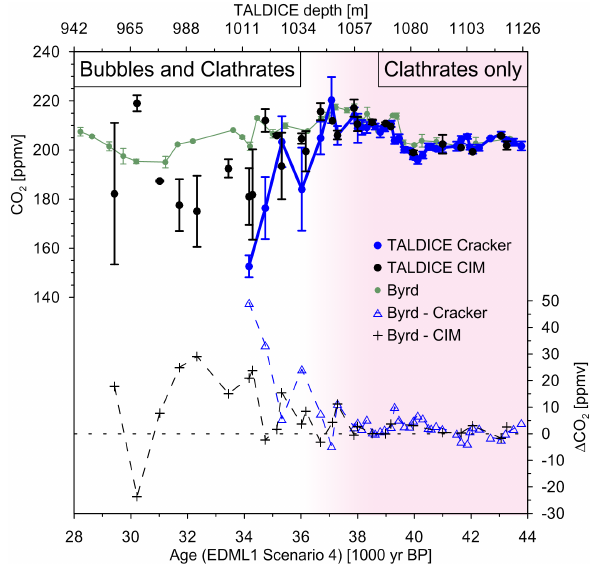
Fig. 6. Top: CO 2 concentrations derived with the CIM system (black dots, this study) and our cracker system (blue dots, Bereiter et al., 2012) using ice samples from the TALDICE core. In green, CO 2 data from the Byrd ice core are shown using an independent cracker system (Ahn and Brook, 2008). The records are synchronised onto the EDML1 Scenario 4 gas age scale (Ruth et al., 2007) accord- ing to Bereiter et al. (2012). Bottom: CO 2 concentration differences inferred between the different records of the top part using linear interpolation: blue triangles represent the differences between the green and the blue records; black crosses between the green and the black records. The white area represents the part of the TALDICE core located in the BCTZ, the pink area the fully clathrated ice. The Byrd ice core covers the entire time window in fully clathrated ice. All the CIM results are obtained with the CIM setting to produce “coarse” ice powder (see Fig. 3). The CIM data points with an error bar consist of two to six single measurements, those without a bar of only